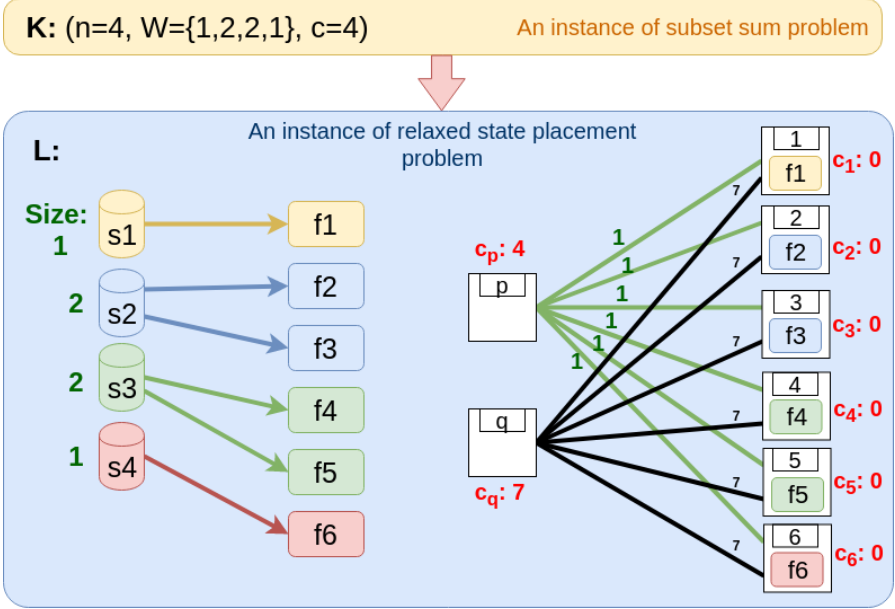
Figure 4. An example for reduction of the Subset sum problem to the state placement